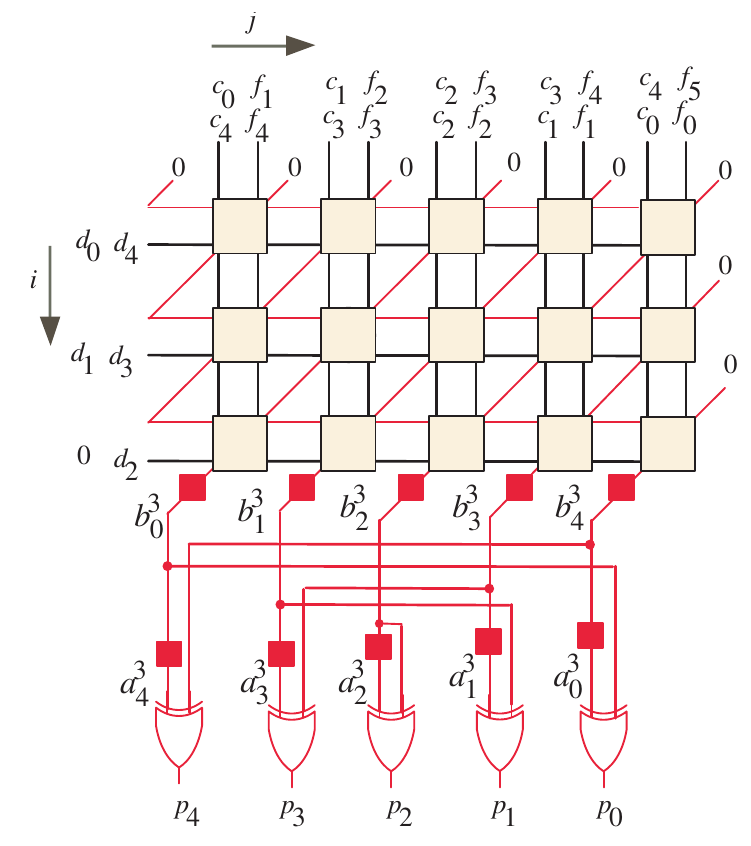
Figure 1. DG of the Montgomery algorithm for m =